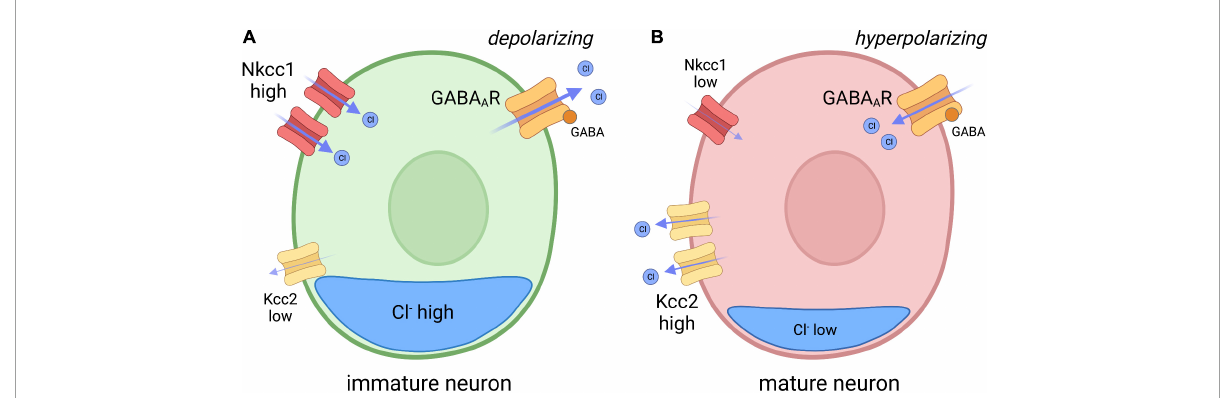
FIGURE1 Model depicting chloride (CI) transporter expression in immature and mature neurons. (A) In immature neurons, the Nkcc1 Cl − importer is highly expressed, while the Kcc2 Cl − exporter expression is low, resulting in high internal chloride concentration. As GABA A receptors (GABA A R) are Cl − permeable, GABA reception spurs depolarization of the membrane through Cl − efflux. (B) In mature neurons, Kcc2 expression is increased, resulting in reduced internal Cl − concentration compared to immature neurons. GABA binding to GABA A R in mature neurons therefore drives hyperpolarization. Inspired by Ben-Ari, Trends in Neurosciences, 2017.